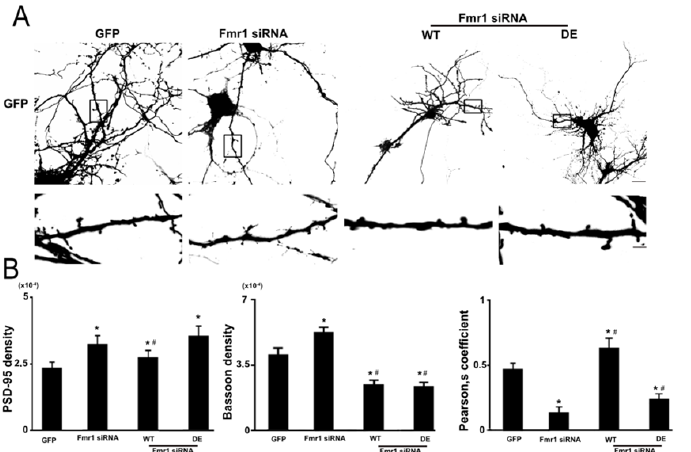
Figure 2. The dendritic spines and synaptic formation defects of mature Fmr1 siRNA neurons are rescued by the RACK1 mutant up-regulation. ( A ) GFP immunofluorescence on 11 DIV neurons co-transfected with GFP and Fmr1 siRNA / WT or Fmr1 siRNA/DE. ( Lower ) In the box is the mag- nification of neuritis. Scale 20 µ m upper and 5 µ m lower. ( B ) Graphic of PSD-95, Bassoon density and Pearson’s coefficient of puncta between PSD-95 and Bassoon measured by immunofluorescence experiments as also reported in Figure 1. Graph reporting the correlation measured by Pearson coefficient of the puncta signal between PSD-95 and Bassoon in Supplemental Figure S2. All bar represent mean ± SD; n.70 puncta from three independent experiments. One-way ANOVA with Tukey’s Post Hoc test. * p ≤ 0.005, vs. GFP, # p ≤ 0.001 vs. Fmr1